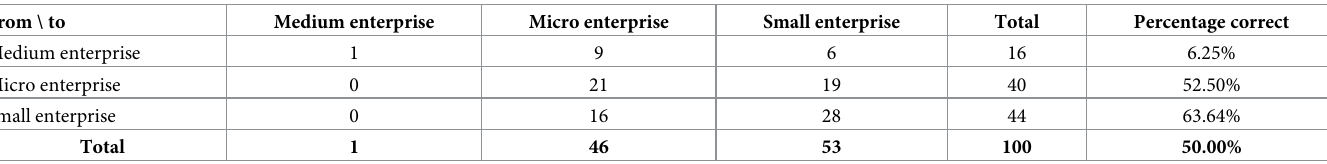
Table 15. Confusion matrix for different companies of inter-organizational trust. From \ to